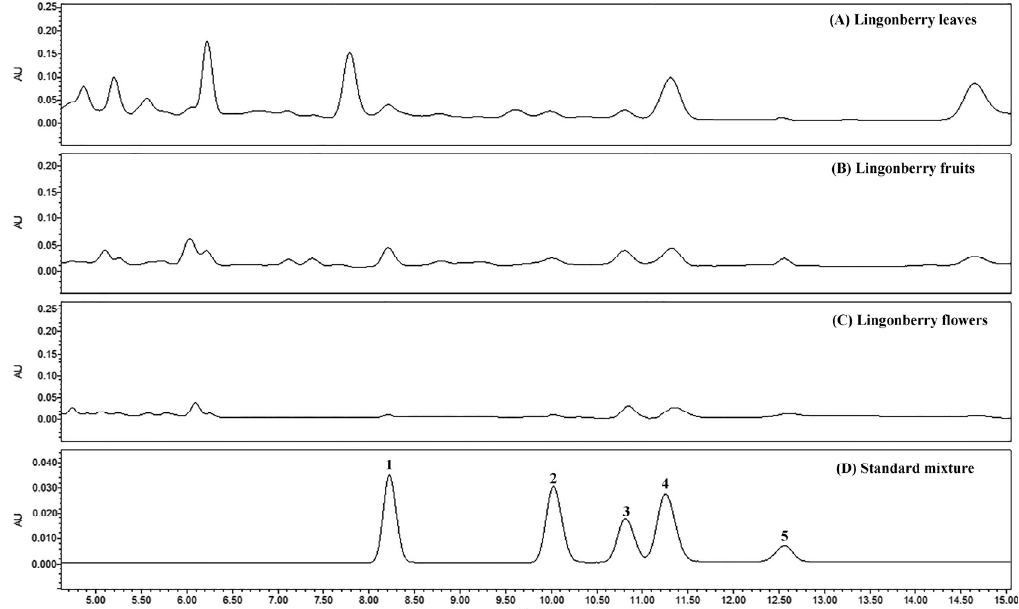
Figure 2. Representative HPLC-PDA chromatograms ( λ = 205 nm) of extracts of lingonberry ( A ) leaves, ( B ) fruits, ( C ) flowers, and ( D ) standard mixture, showing the separation of phytosterol and neutral triterpenoids, which lack chromophores. Peak